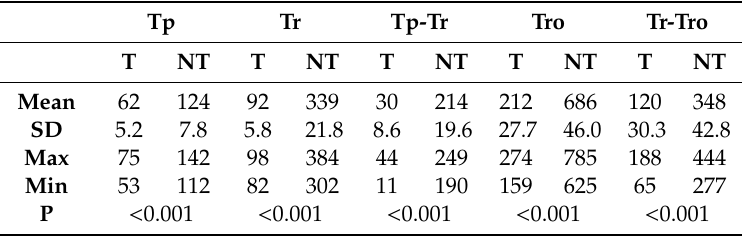
Table 2. Mean, standard deviation (SD), maximum (Max) and minimum (Min) values for the Time to ponding (Tp), Time to runo ff (Tr), Tp-Tr, Time to runo ff outlet (Tro). T: Tillage; NT: No-Tillage. Tp Tr Tp-Tr